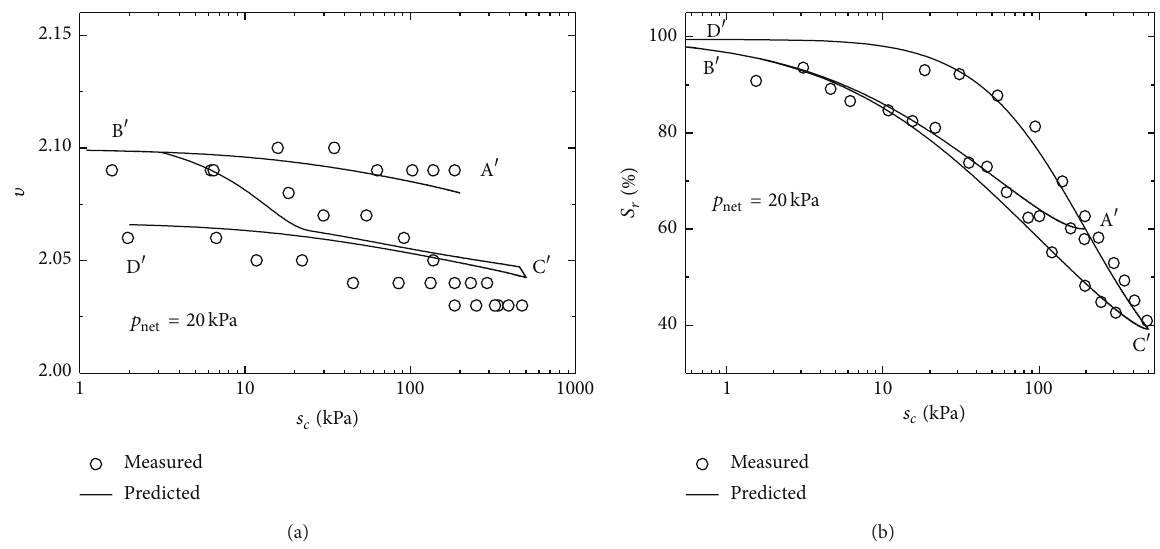
Figure 11: Response of Pearl clay under wetting-drying cycles: (a) relation between matric suction and specific volume; (b) soil-water characteristic curve (data after Sun et al. (2006)